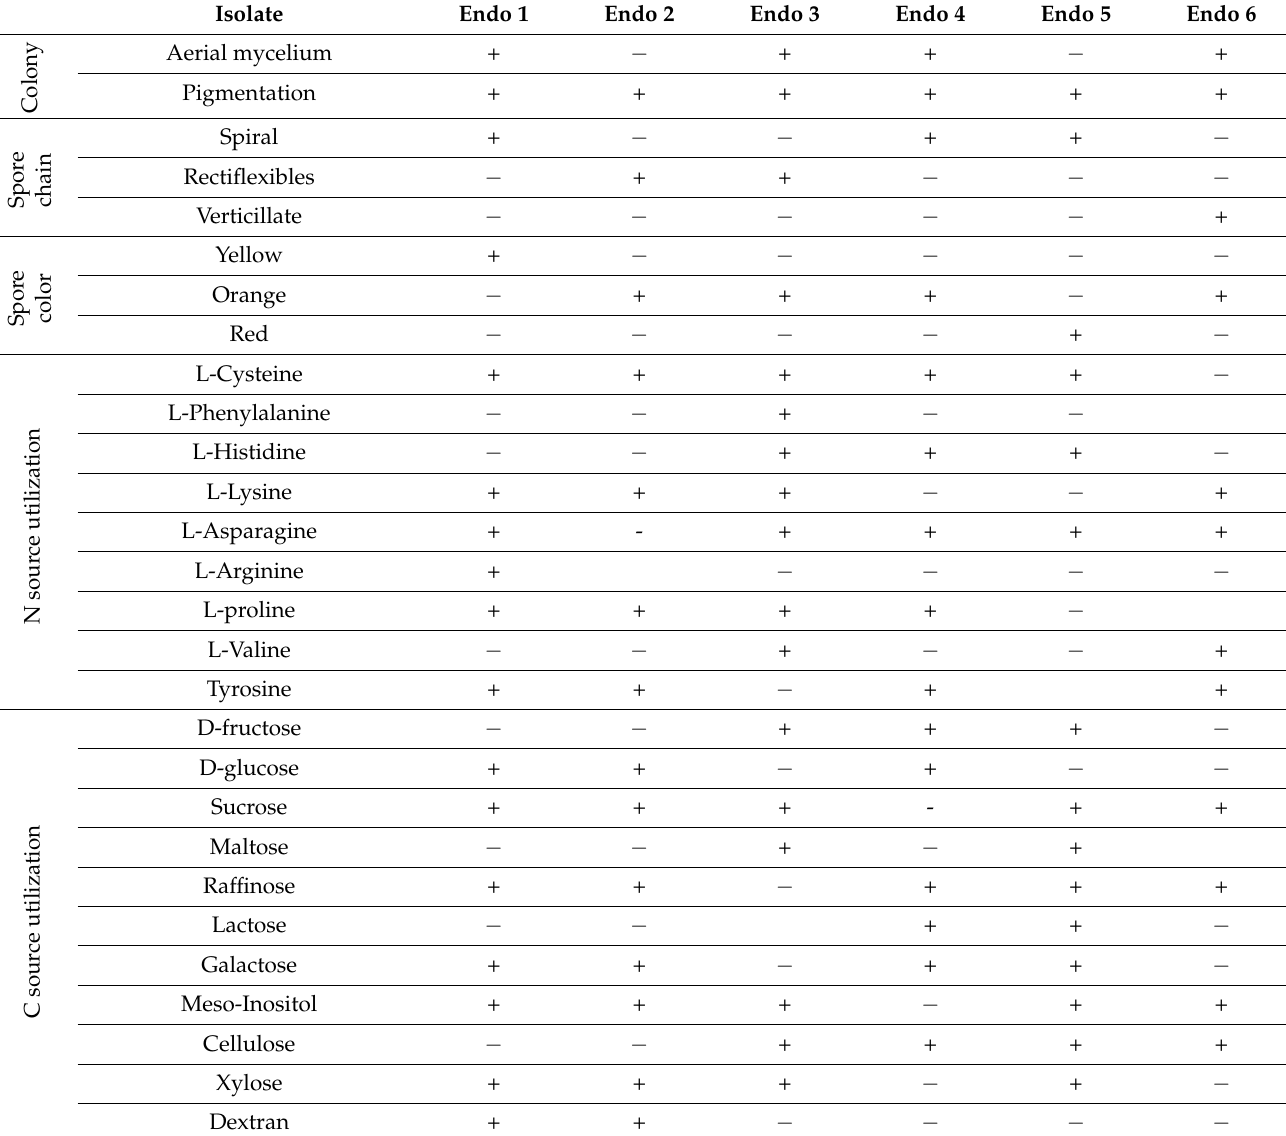
Table 1. The morphological and biochemical characterization of bacterial isolates, whereas the signs + and − indicate presence or absence, respectively. Data are represented by the means of at least 3 replicates, and error bars represent standard